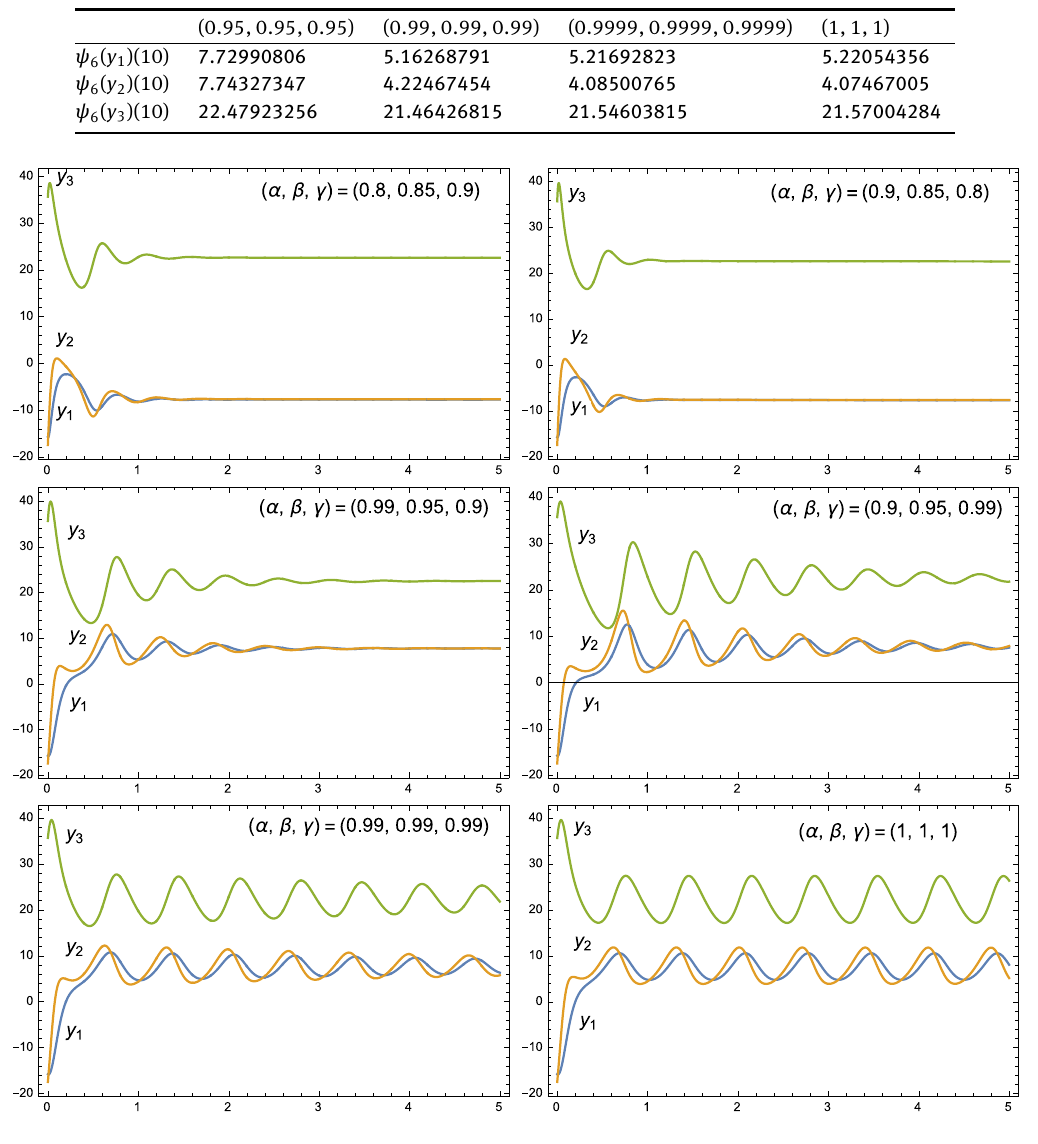
Table 9: The values of ψ 6 ( y )(10) for h = 0.05 and various values of ( α , β , γ ) for Example 6.